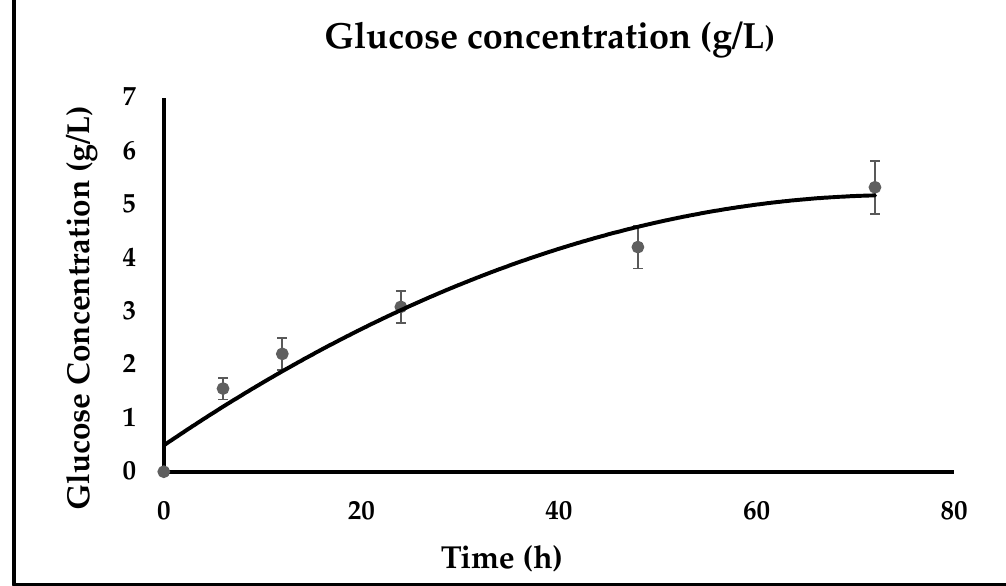
Figure 5. Enzymatic saccharification kinetics.